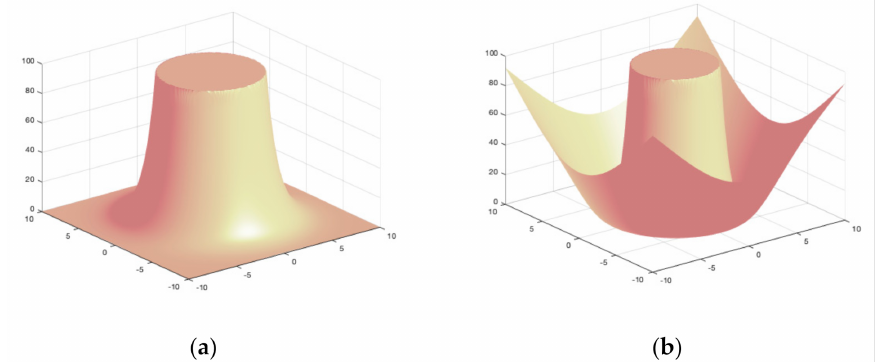
Figure 5. The comparison of exponential functions of repulsive potential forces ( a ) and traditional repulsive potential fields ( b ). ( a ) No need to set threshold value and ( b ) should consider the distance threshold to remove the unintended potential